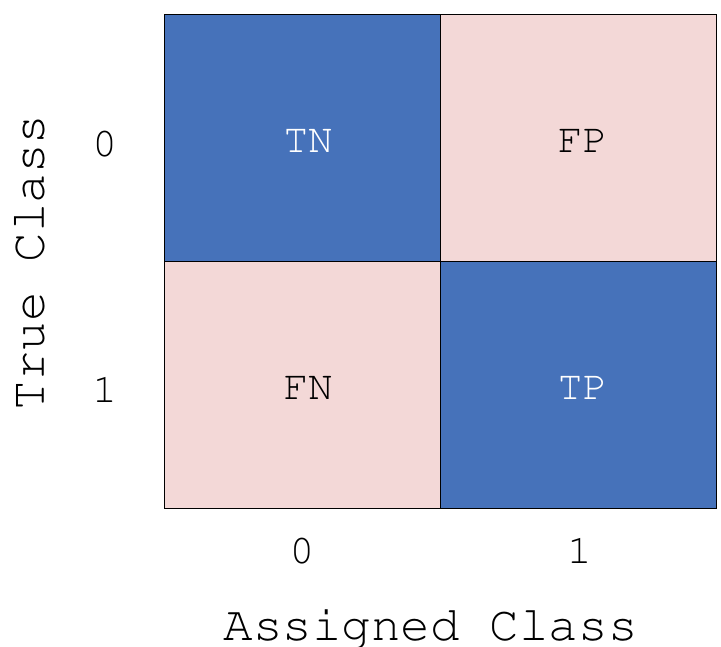
Figure 13. Confusion (contingency)